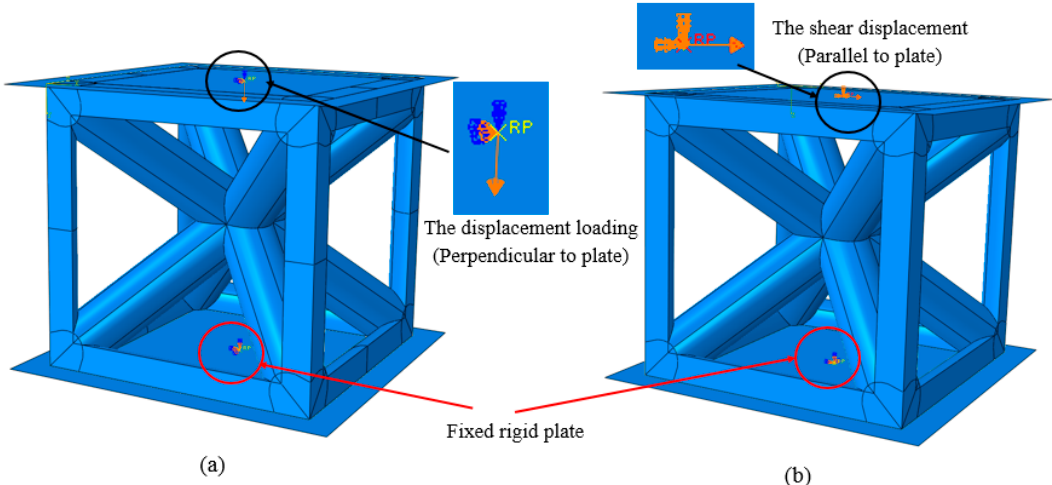
Figure 7. ( a ) Boundary conditions of the unit cell FEA model for the elastic modulus and Poisson’s ratio in all three directions x , y , and z . ( b ) Boundary conditions of the unit cell FEA model for the shear modulus in all three directions x , y , and z .